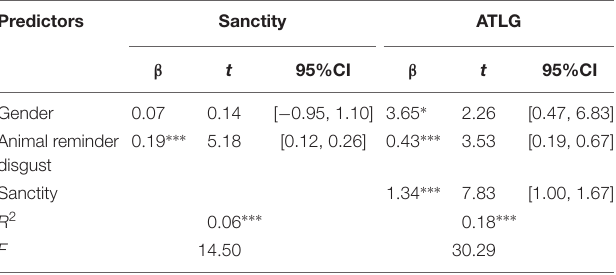
TABLE 5 | Individual associations between variables in the mediation model, where sanctity was hypothesized to mediate the association between animal reminder disgust and ATLG ( N = 452).